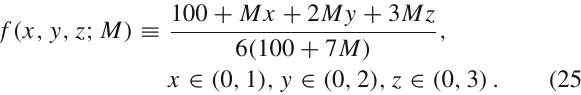
(c) f x f y f z . Finally, this case corresponds to the